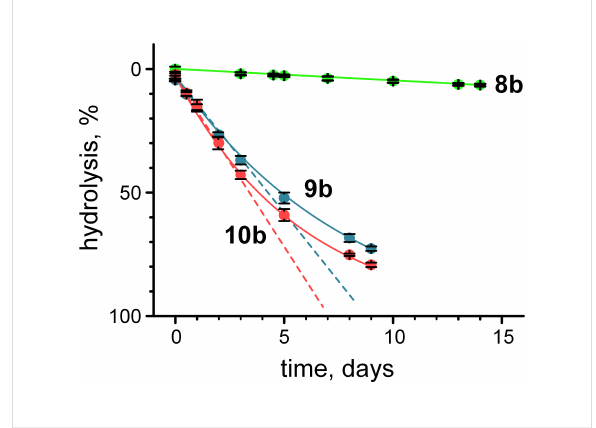
Figure 7: Hydrolysis of the C-terminal 2,2-difluoroethyl esters of the oligopeptides in buffered deuterium oxide at 298 K and pH 7. Dashed lines reflect the pseudo zero-order kinetic behavior of hydrolysis during the initial stages of this